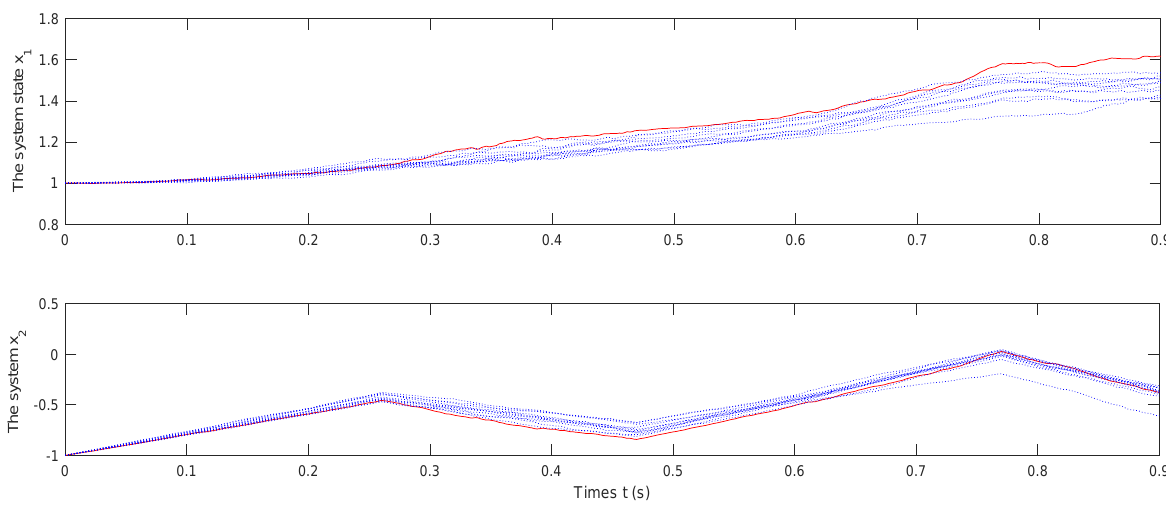
Figure 5. The cost function J ( τ ( k )) and the gradient function (cid:107) dJ ( τ ( k )) (cid:107) with k iterations.